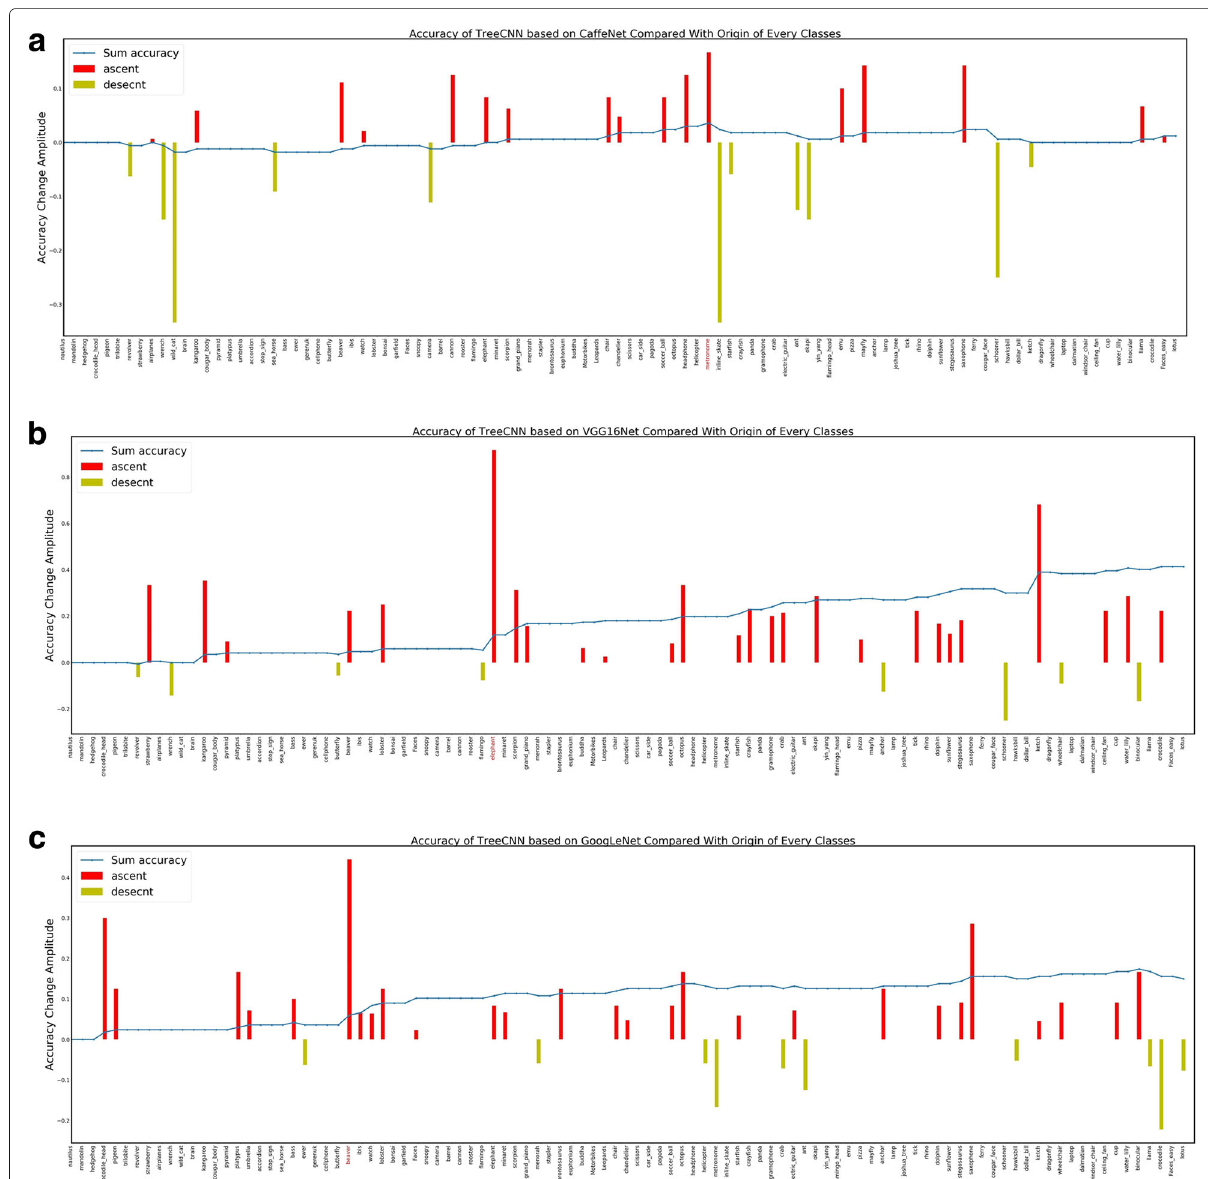
Fig. 5 Tree-CNN accuracy compared with the original CNN accuracy of every category in Caltech101. a – c CaffeNet, VGG16, and GoogLeNet. The red bar represents the accuracy of the Tree-CNN which is higher than the original CNN in this category. The yellow bar represents the accuracy of the Tree-CNN which is lower than the original CNN in this category. The curve shows that the average accuracy variation changes with the increase in categories, and the average accuracy variation had been magnified ten